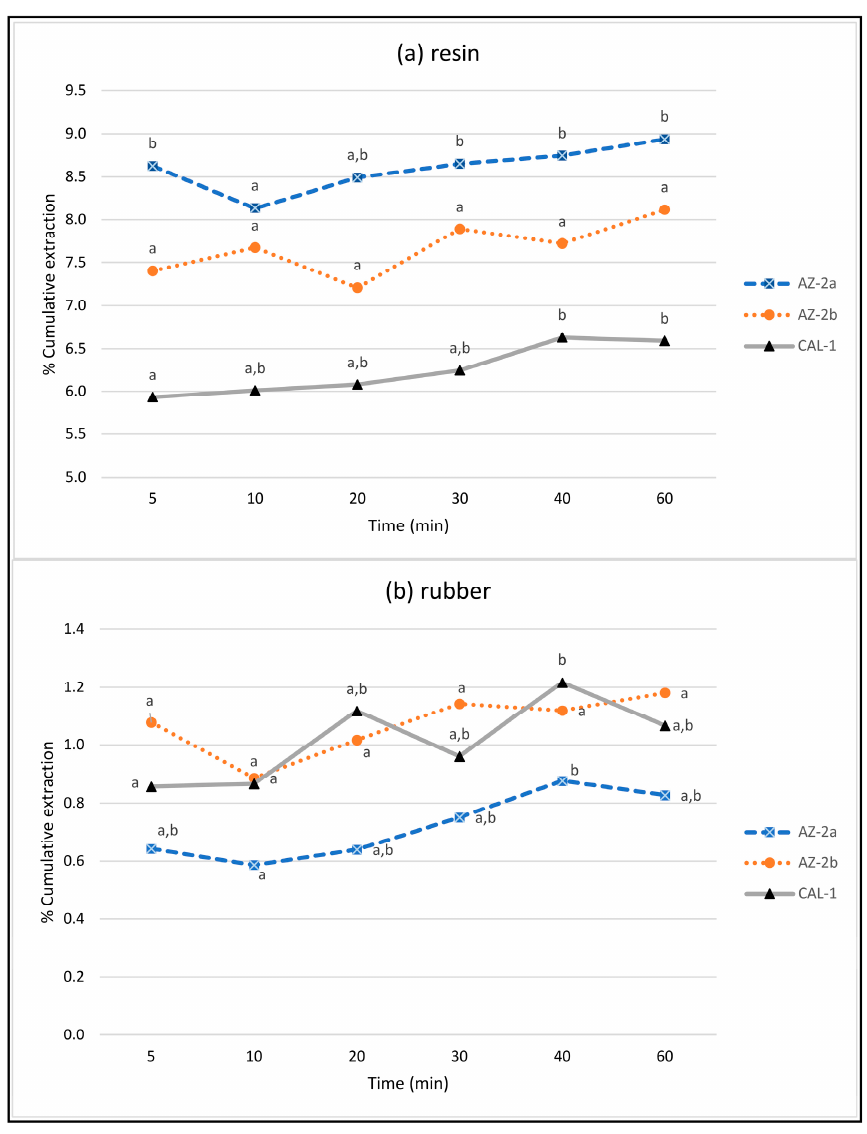
Figure 3. Cumulative resin ( a ) and rubber ( b ) extraction yield depending on the extraction time without considering the number of cycles. Comparisons were made between 2 accessions (AZ-2 and CAL1), with the AZ-2 accession originating from two different plots (AZ-2a and AZ-2b). Different letters within the same accession and product extracted denote statistically significant differences between the yields at any extraction time at a 95% level of confidence.